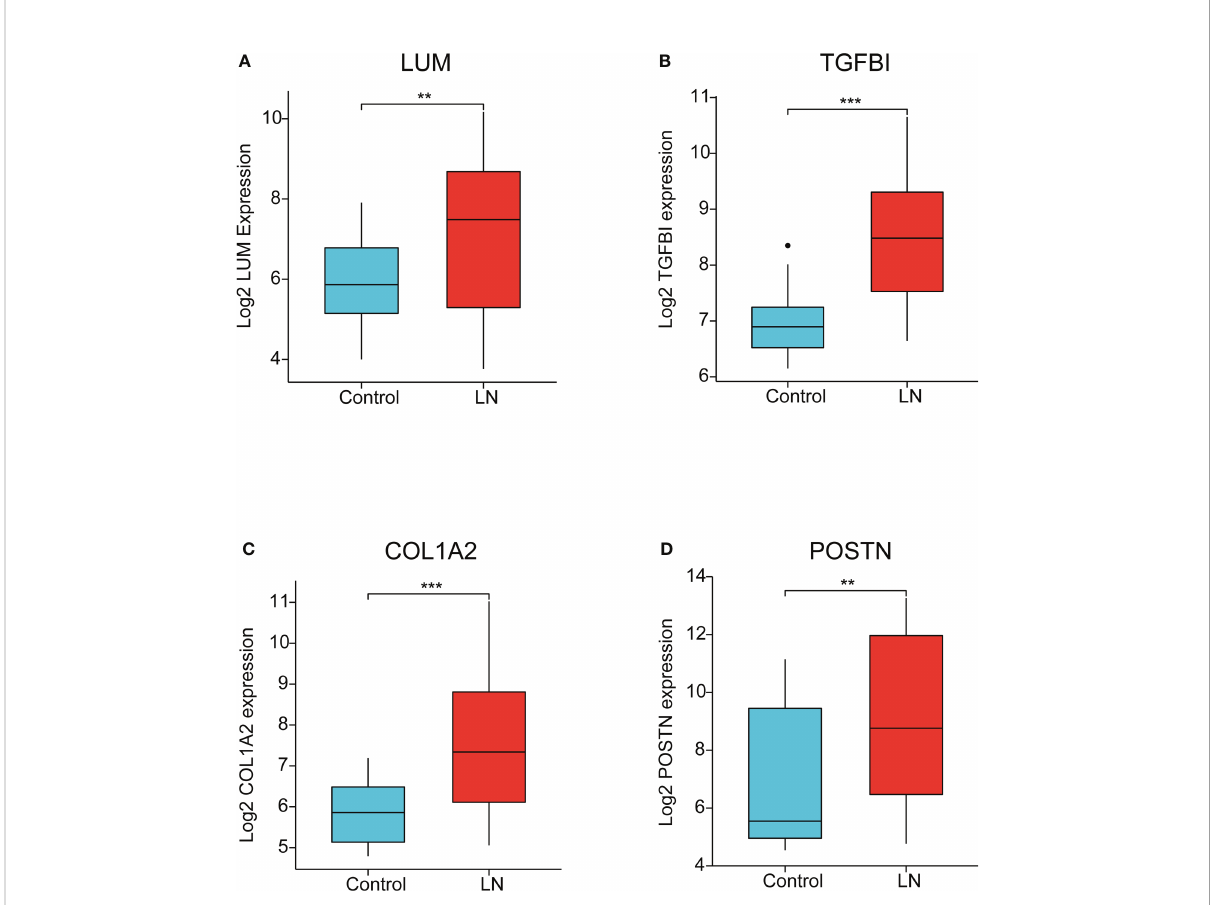
FIGURE 7 The expression of key EP-DEGs identi fi ed as the potential biomarkers. (A-D) The expression level of LUM, TGFBI, COL1A2, and POSTN between LN and control groups, respectively. (**P < 0.01 and ***P <